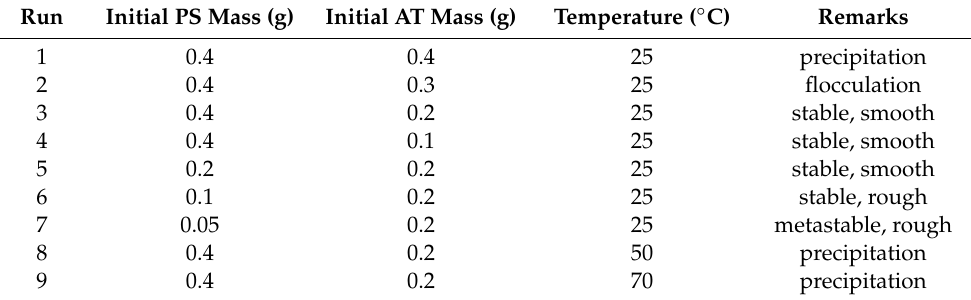
Table 1. Summary of the PAT-coated PS particles prepared under different conditions. The total water content was fixed to be 50 g.